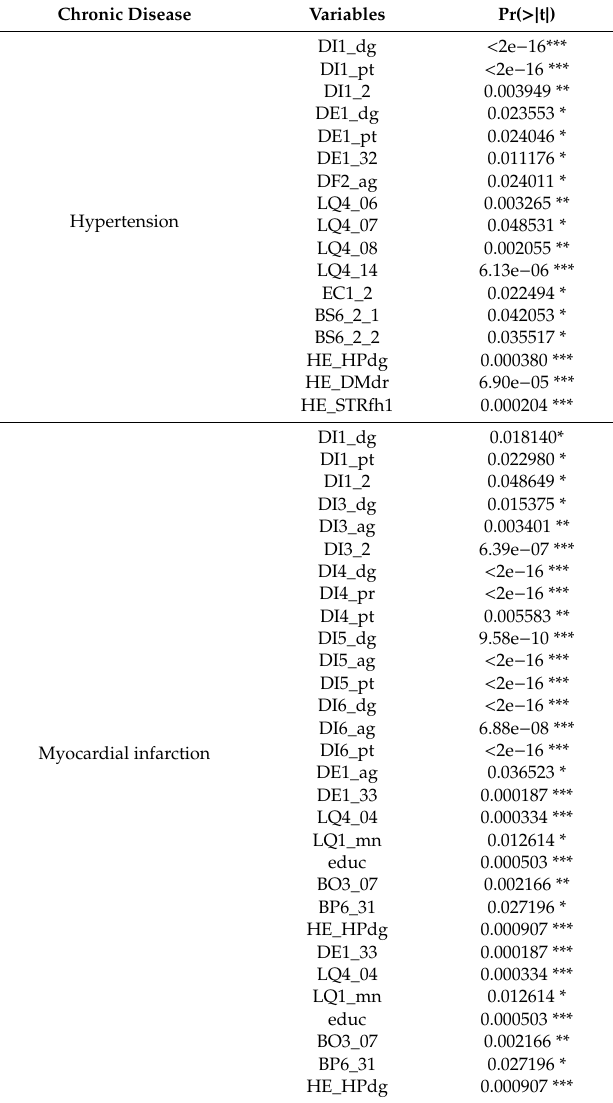
Table A1. Chronic disease variables,